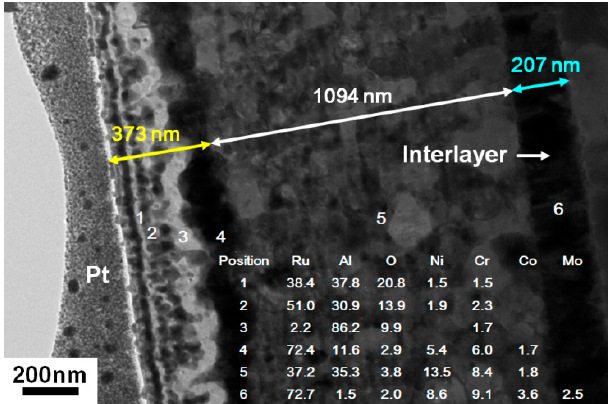
Figure 11. Cross-sectional TEM image and energy dispersive spectrometry (EDS) results for the Ru 0.61 Al 0.39 /Ru/Inconel 617 sample after annealing in air at 800 °C for 30 min.